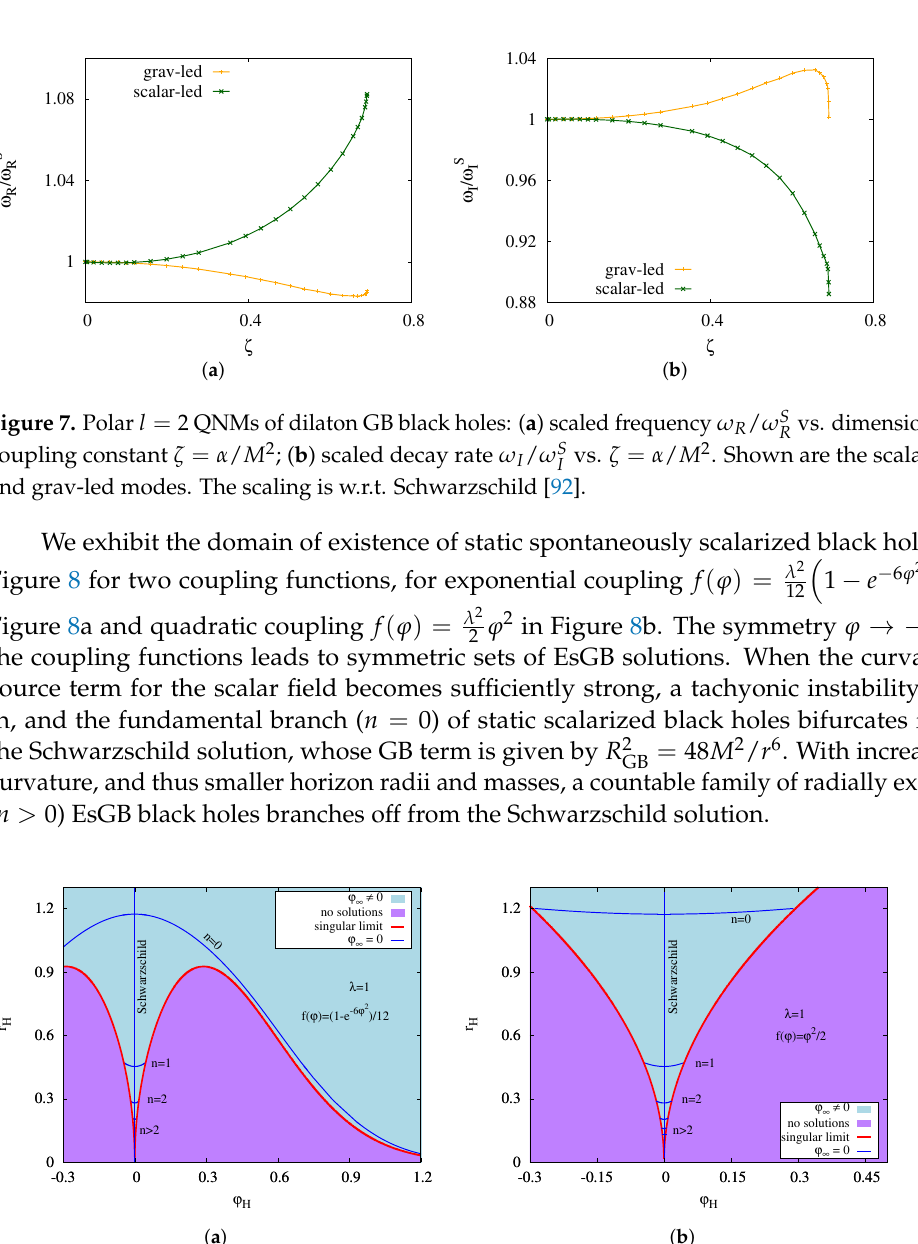
Figure 8. Domain of existence of static spontaneously scalarized EsGB black holes: ( a ) horizon radius r H vs. horizon scalar field ϕ H at fixed GB coupling λ = 1 for exponential coupling function; ( b ) same for quadratic coupling function. Shown are the fundamental mode n = 0, and the lowest radially excited modes n = 1 and 2. The colors indicate forbidden regions